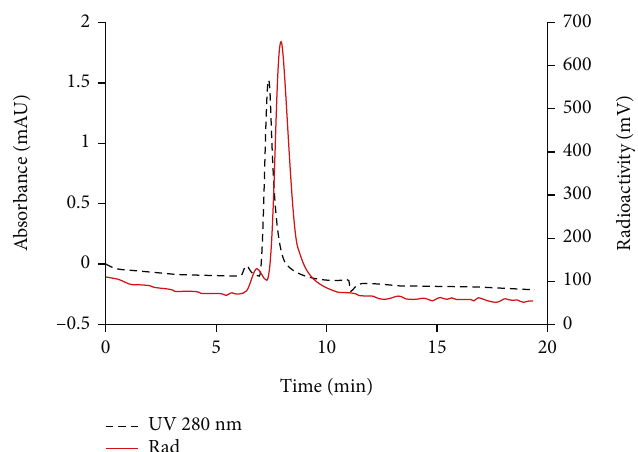
Figure 1: A representative HPLC of [ 89 Zr]Zr-DFO-NC318. HPLC condition: eluent, 0.1M sodium phosphate, 0.1M sodium sulfate, 0.05% sodium azide, 10% isopropyl alcohol (pH6.8), and fl ow rate